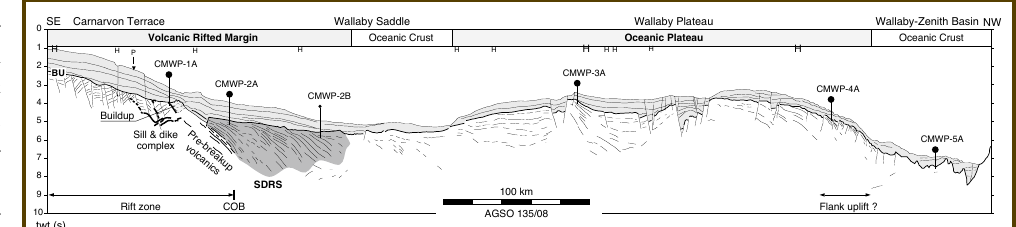
Figure 11. Interpreted seismic profile across the southern Cuvier margin and Wallaby Plateau with proposed IODP sites. COB: continent-ocean boundary; BU: breakup unconformity. See Fig. 10 for location of profile.